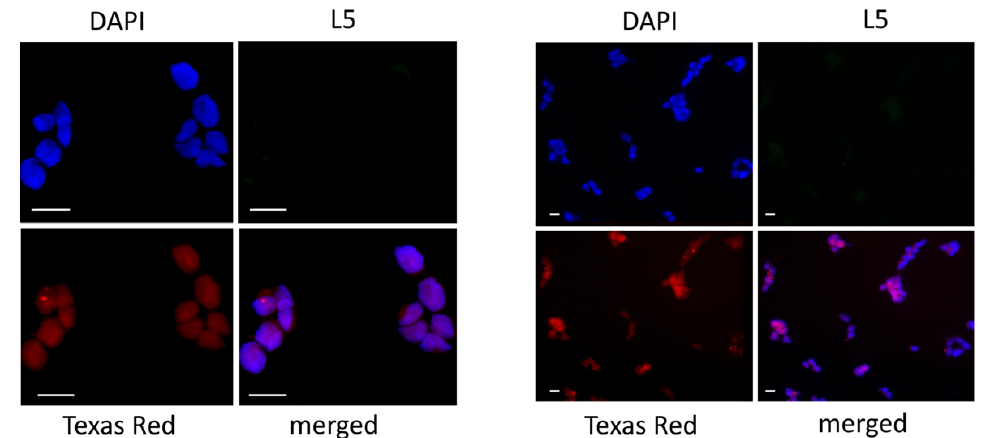
Figure 7. Fluorescence microscope images of hFOB.19 incubated with CB-Green ( left ) and with CB-Green@MSN ( right ). Bar = 1 μ m.